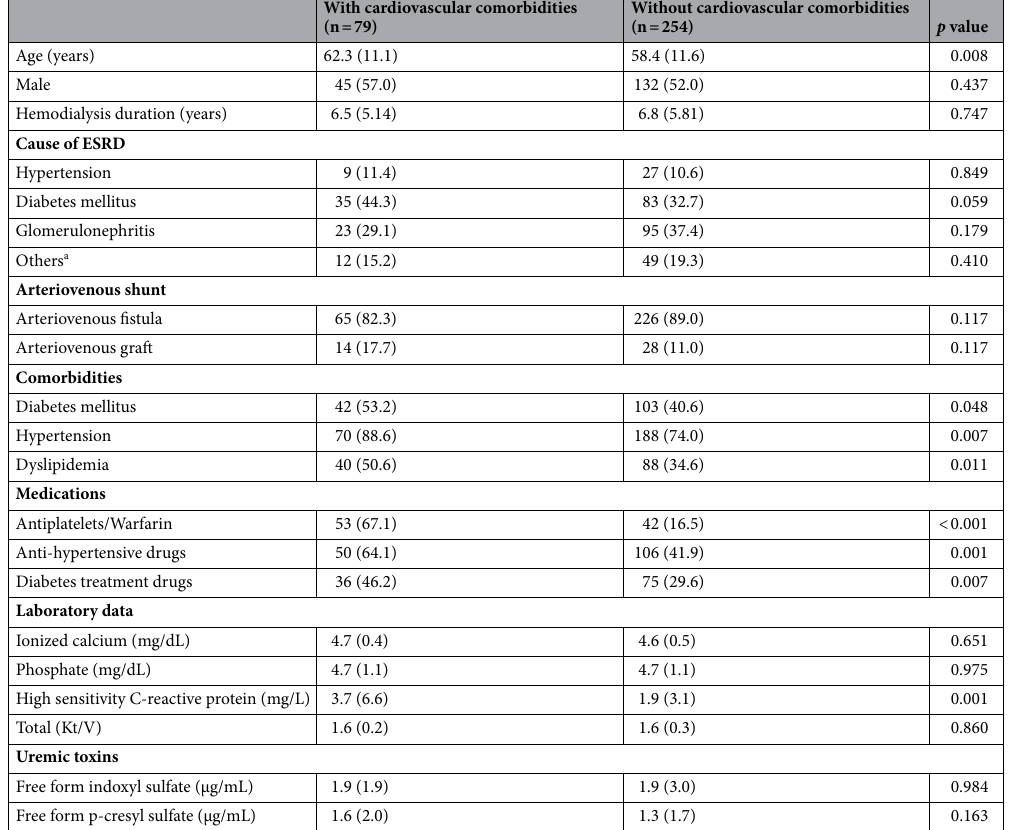
Table 1. Baseline characteristics of hemodialysis participants with and without overt cardiovascular comorbidities (coronary artery disease or cerebrovascular disease). a Other causes of end-stage renal disease include polycystic kidney disease, tumor, systemic lupus erythematosus, gout, interstitial